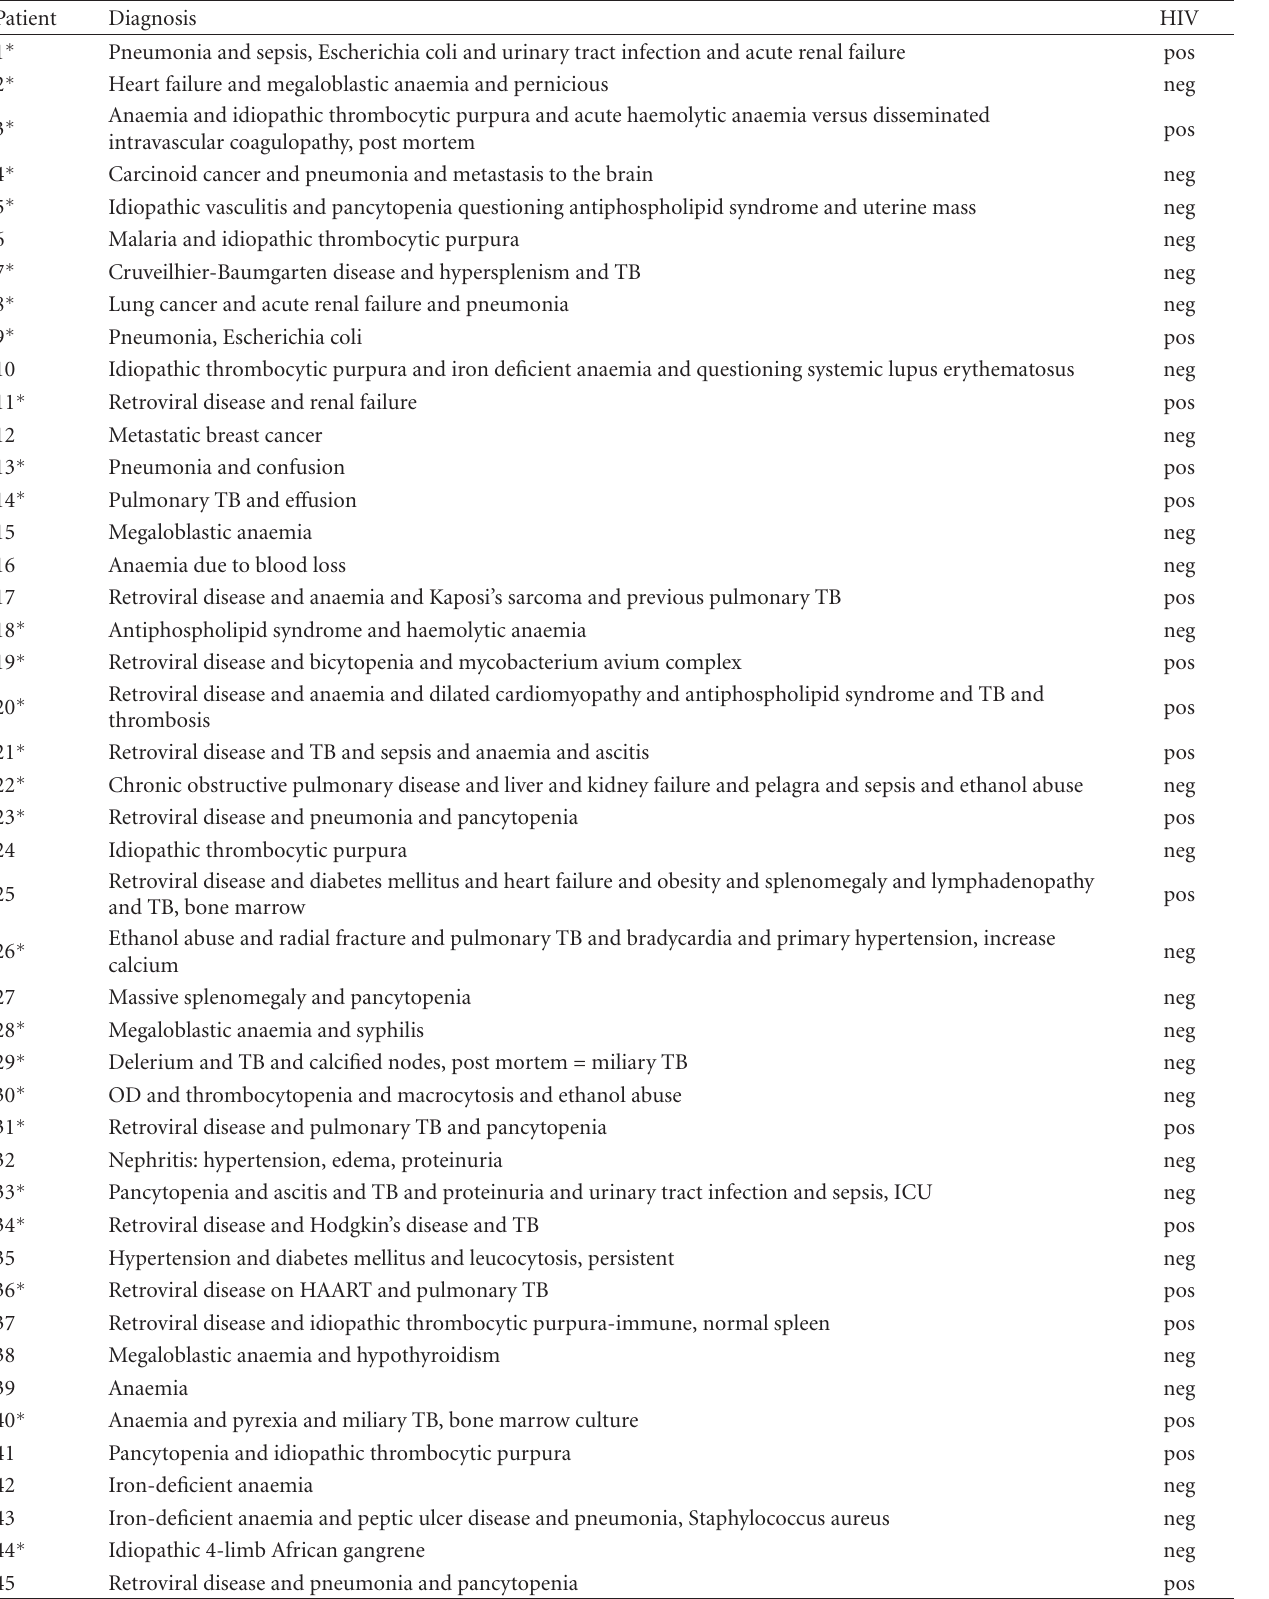
Table 1: Diagnosis and HIV status of the patients ( ∗ elevated